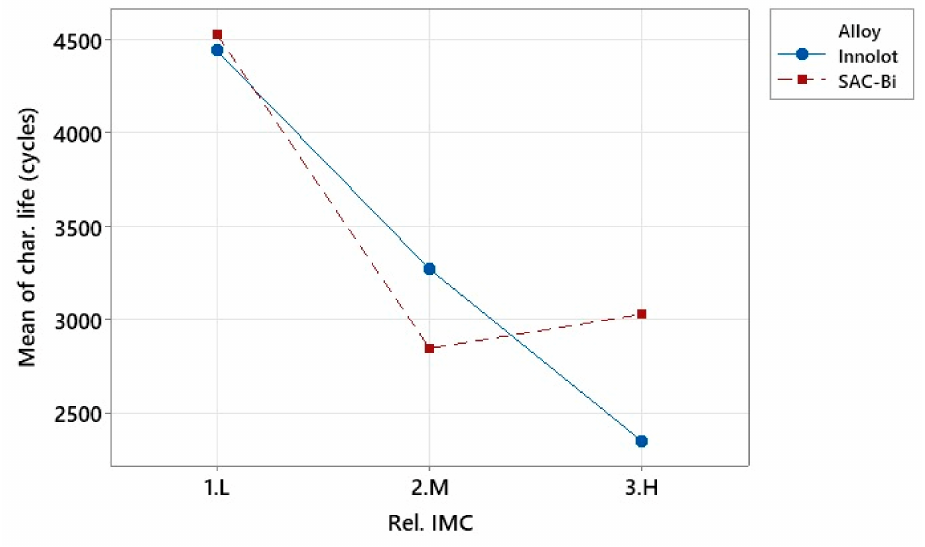
Figure 10. ANOVA analysis for interaction plot between alloy and rel. IMC layer thickness.